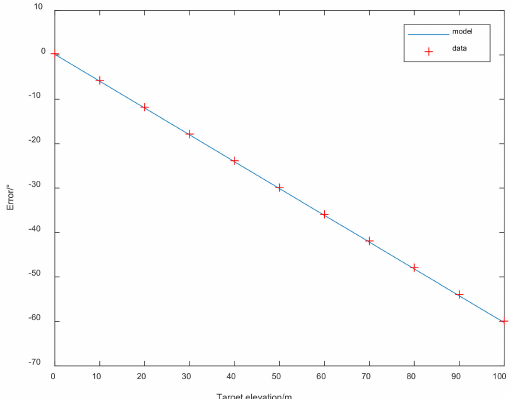
Figure 6. The calculated polarimetric interferometry phase error, using the proposed model. The blue line presents PolInSAR phase error calculated from the proposed model, and the red points present the phase error of simulated UAV-borne PolInSAR